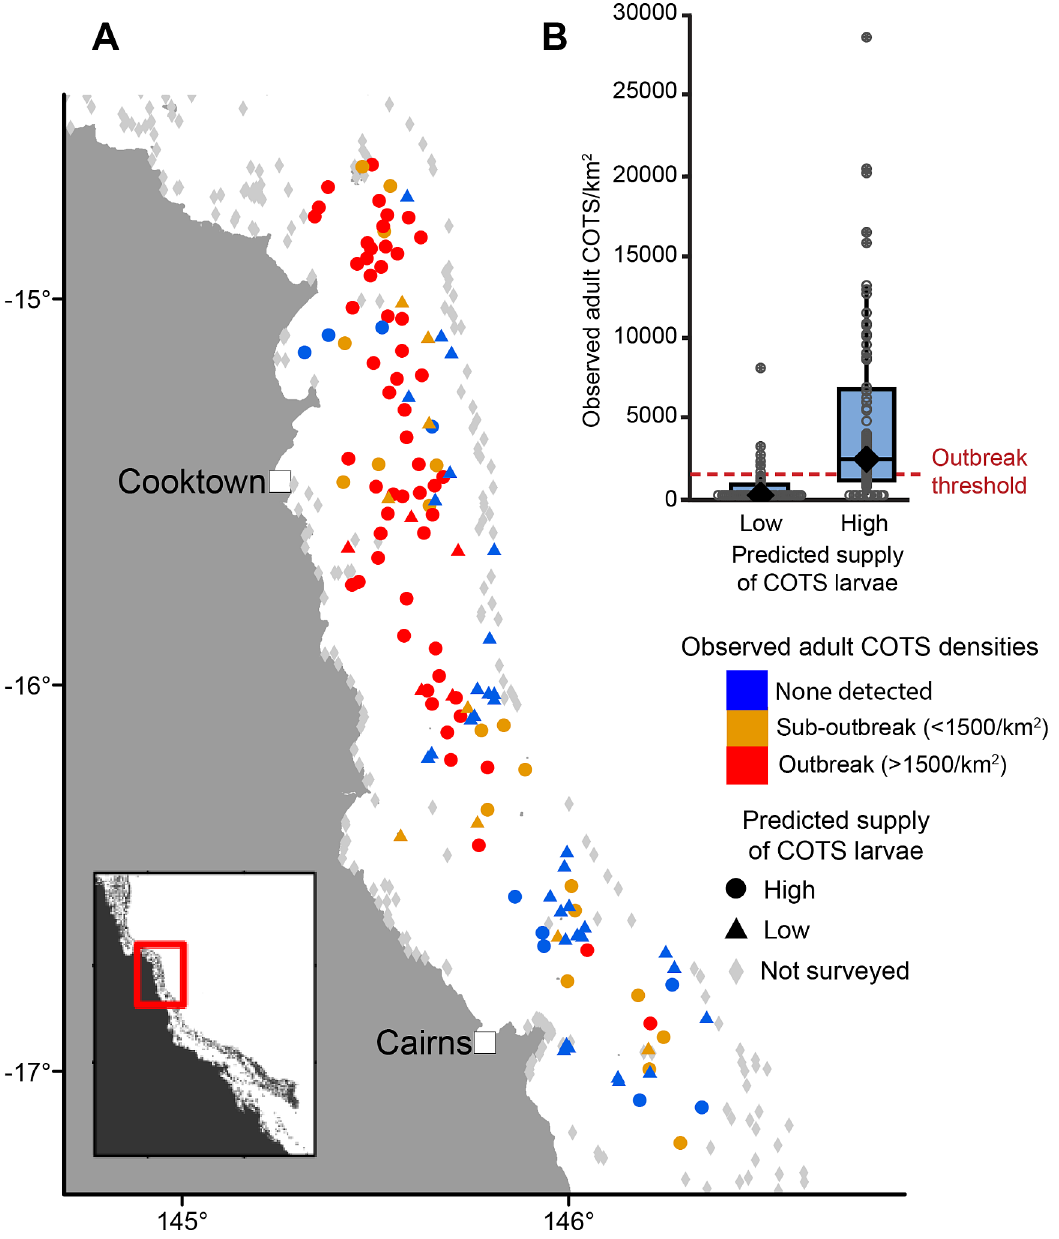
Fig 3. Linking connectivity and COTS abundance estimatesfrom field surveys. (A) A map of the GBR region surveyedfor COTS in 2013–2015.Reefs with low predictedsupply of COTS larvae(triangles; N = 48) were more likely to have low levels of adult COTS or no adult COTS detected (blue symbols). The highest incidenceof COTS outbreaks(red) was observedon reefs with high potentialsupply of COTS larvae (circles; N = 89). Note that, although the outbreaks originatedin the area north of Cooktown and spreadsouthwards,latitudeand longitudewere not significantpredictors in the analysis,but they were kept in the model as covariatesto ensure that any spatial pattern observedin the figure did not affect the observedeffect of connectivity. (B) Reefs with high predicted supply of COTS larvae had significantly higher densitiesof adult COTS. The outbreak thresholdof 1,500 adult COTS km − 2 is shown as a red line [30]. The box plots show medians(black diamonds)and quartiles(blue box). The analysisalso includeda datum in the high category with an estimated COTS density of > 30,000per km 2 . Data providedin S1 Data. COTS, crown-of-thorns starfish; GBR, Great Barrier